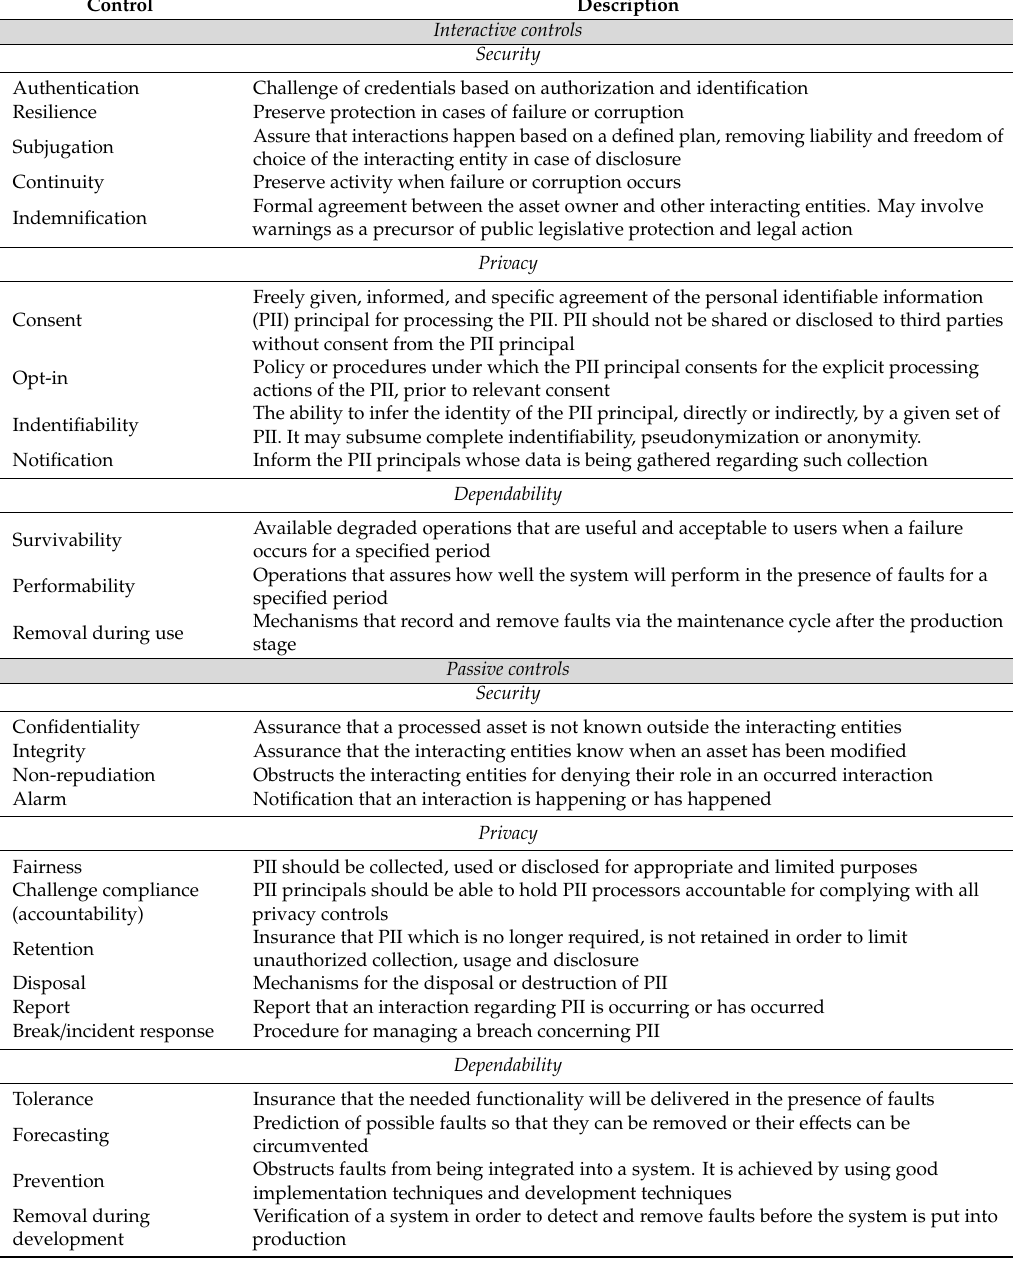
Table A1. The SPD controls that are evaluated by the SPD methodology. Description Interactive